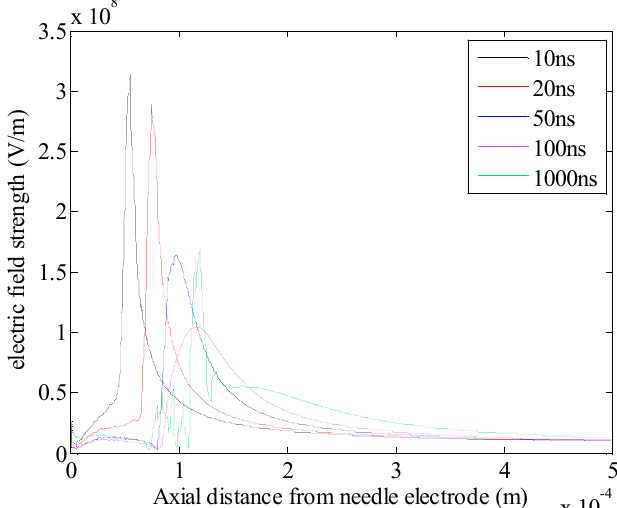
Figure 10. Electric field distribution along the needle-sphere axis as a response to 1.5 PDIV with 10 mm needle-sphere electrode